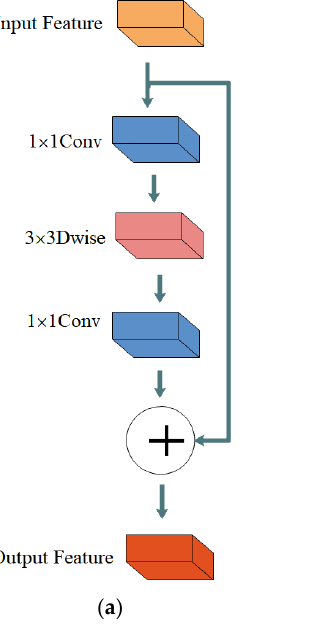
Figure 6. Inverted residual structure with linear bottleneck. ( a ) Stride was one. ( b ) Stride was two. Where: Conv represents convolution layer. Dwise represents the Depthwise convolution layer.